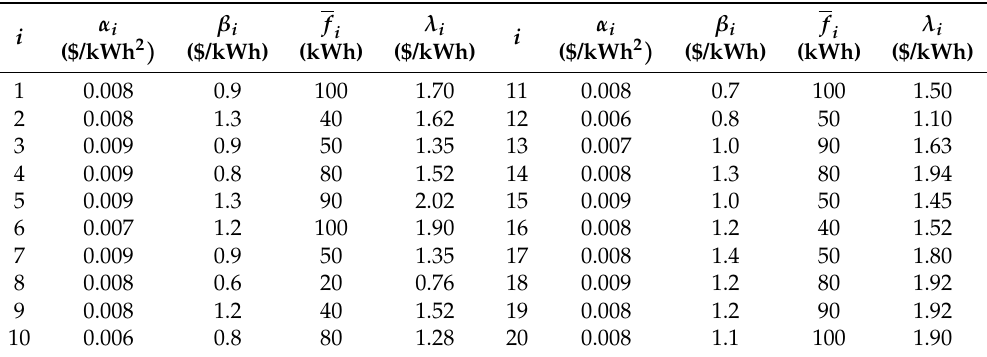
Figure 8. Technical architecture of the Monash Microgrid software solution. Table 2. Agents’